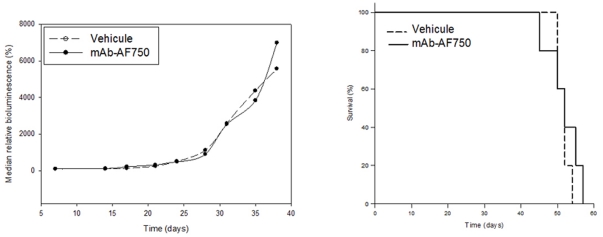
Effects of fluorescent CD45 mAb intravenously administered over three weeks on the bioluminescence signal of HL60-Luc tumor-bearing mice (A) and on life span (B).